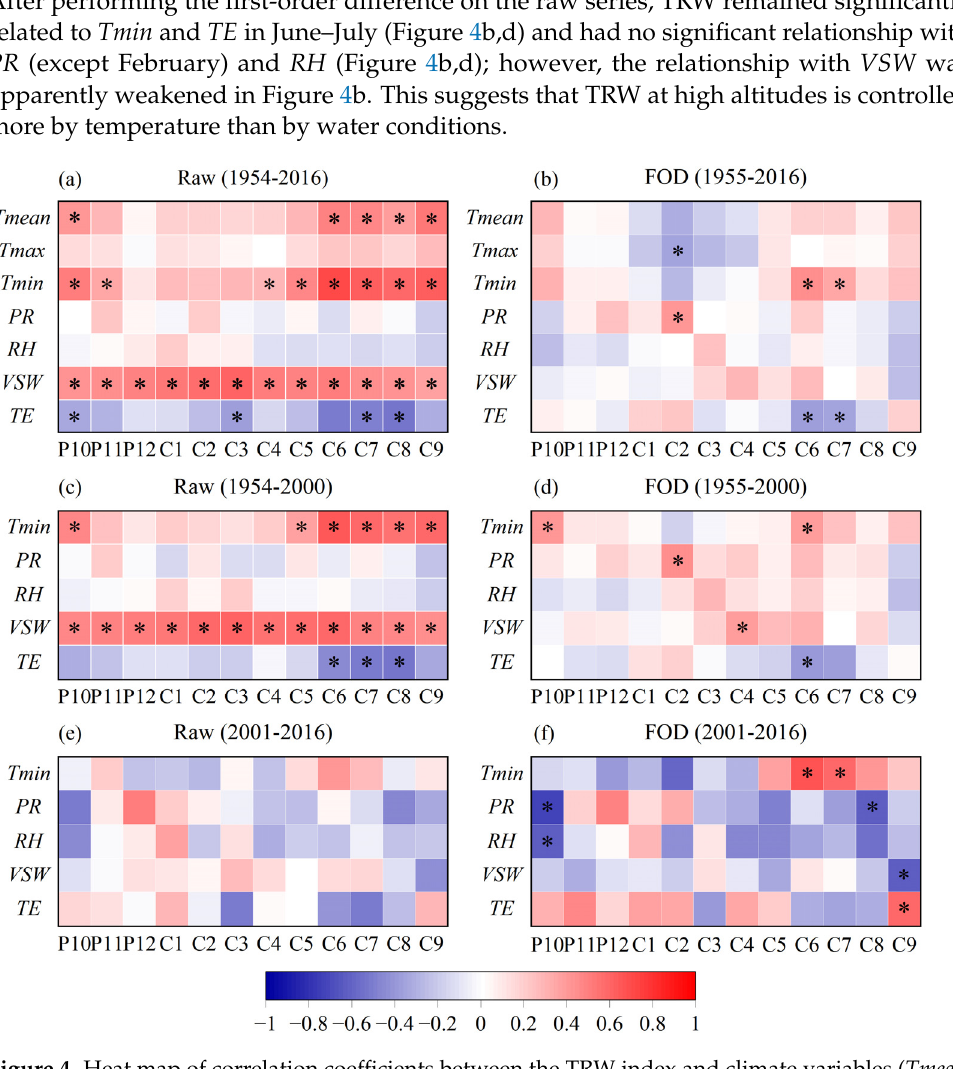
Figure 4. Heat map of correlation coefficients between the TRW index and climate variables ( Tmean , Tmax , Tmin , PR , VSW , TE ), including correlation coefficients between the raw series and first-order difference (FOD) series at different periods. P10–C9 represents October of the previous year to September of the current year. The * represents the correlation coefficient exceeding the 99% significance level.